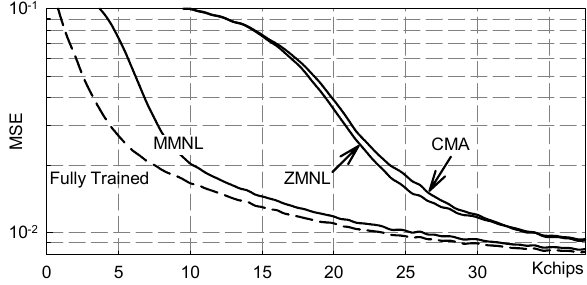
Figure 8. MSE vs. transmitted chips: channel (20), NSR = 20